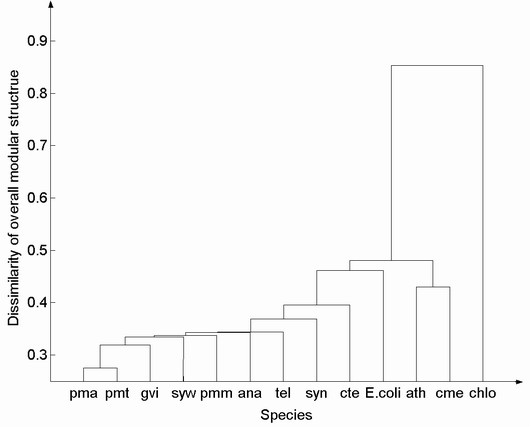
Similarity of overall modular structures among chloroplasts, photosynthetic bacteria, E.coli, Arabidopsis thaliana and Cyanidioschyzon merolae.